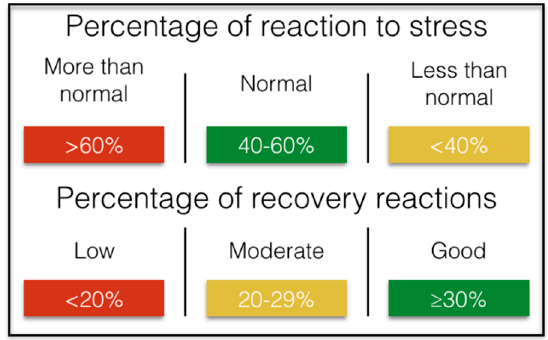
Figure 6. Values expressed in percentage of the impact of stress and recovery on performance.